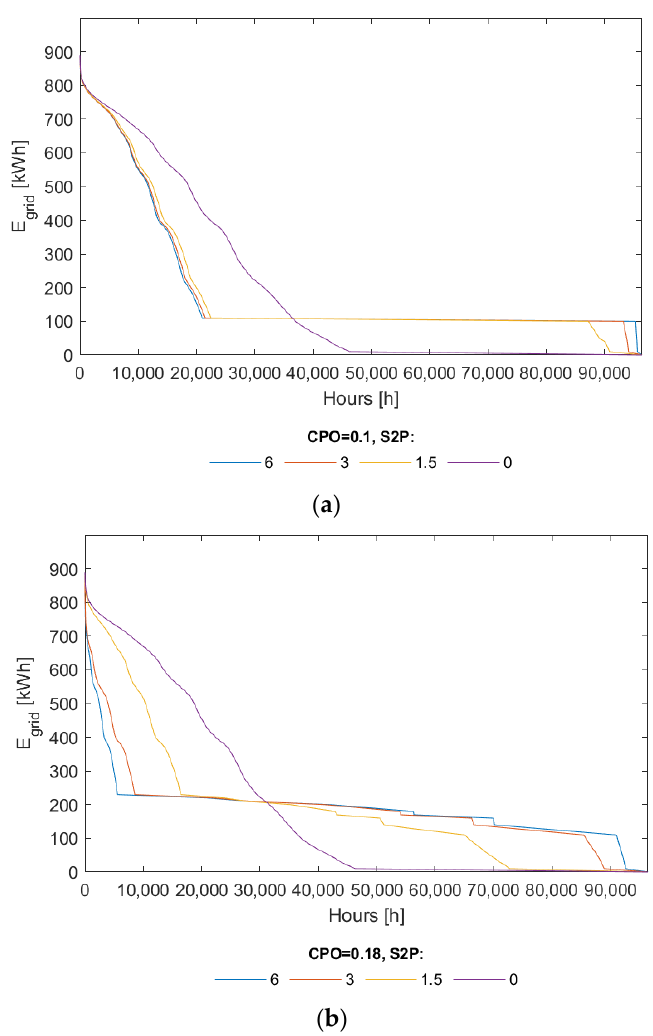
Figure 7. Generation duration curves with fixed CPO factor ( a ) CPO factor= 0.1, ( b ) CPO factor= 0.18, varying S2P.